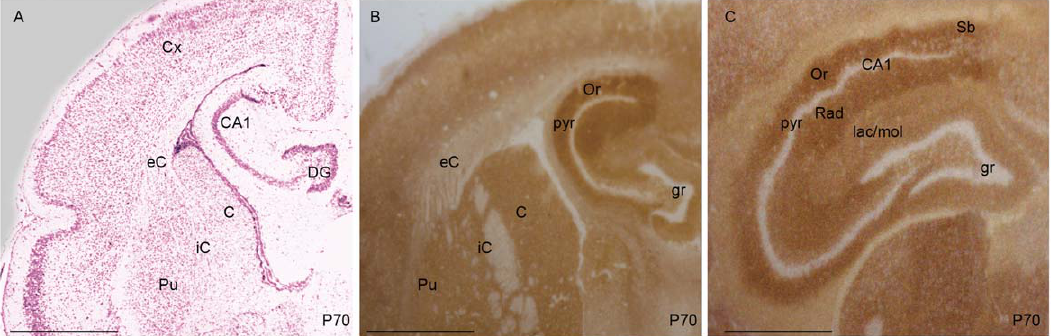
Figure 5. Coronal sections of opossum brain at P70 (A–C). In (A) the coronal section was Nissl-stained. In the adult opossum (B) a strong signal was predominantly present in the hippocampus. Marginal signal was also detected in the caudate nucleus (C), in the internal capsule (iC) and in the putamen (Pu). A very residual signal was observed in the external capsule (eC). In (C) the specific distribution of PrP C in the different hippocampal layers was analyzed. Staining in the lacunosum and moleculare (lac/mol) was lower than in the oriens (Or) and the radiatum (Rad). PrP C immunoreactivity was also observed in the subiculum (Sb) the main output of the hippocampus. (Bars: 0.5 mm).